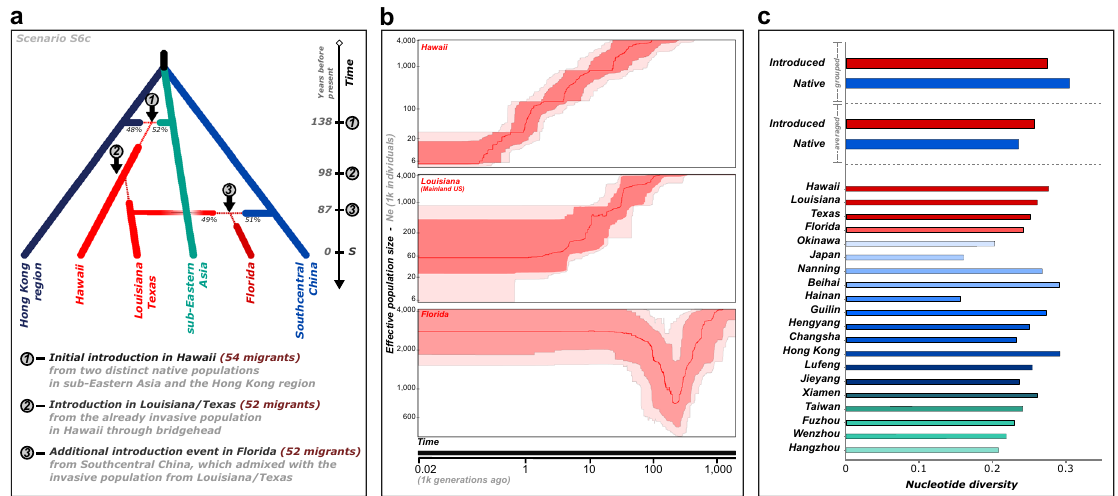
Fig. 5 The invasion history of C. formosanus . a Graphical representation of the most likely invasion history scenario for C. formosanus out of Asia tested through ABC RF. Thin dotted lines represent bottleneck events. Estimated duration of each bottleneck event, as well as all of the posterior parameter estimates are provided in Supplementary Table 11. Time is not to scale, with S indicating sampling time. b Estimation of the variation of effective population size through time for three invasive localities using Stairway Plot 2. The solid red line is the estimate of the median effective population size, and the light and dark red shaded areas represent the 95% and 75% con fi dence intervals, respectively. c Nucleotide diversity in the introduced and native range. All native and introduced localities were fi rst analyzed while grouped together, then